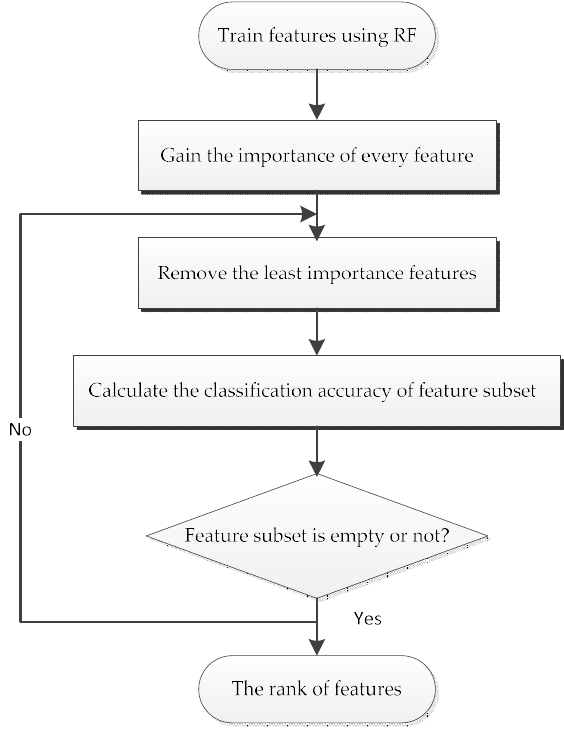
Figure 2. The main procedure of the recursive feature elimination (RFE) method.